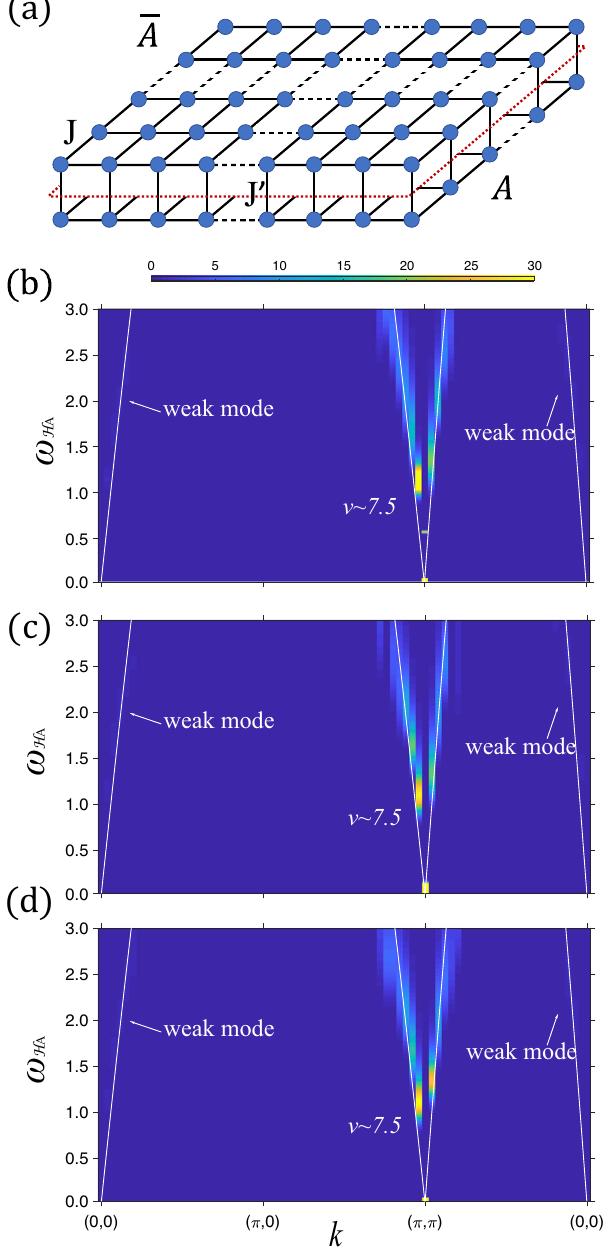
Fig.4|ESofHeisenbergbilayeracross(2+1)O(3)transition.a Antiferromagnetic Heisenbergbilayer.Thereddashedlinecutitintotwoentangledconstituentlayers, A and A . b The low-lying ES of in the Néel phase with L =50, J 0 =1 : 732, J =1 and β =100, β A =32. c The low-lying ES at the quantum critical point with L =50, J 0 =2 : 522, J =1 and β =100, β A =32. d The low-lying ES in the dimerized phase with L =50, J 0 =3, J =1 and β =100, β A =32. We show the obtained ES along the high- symmetry path (0,0) − ( π ,0) − ( π , π ) − (0,0). The white line is fi tting to the data q ffiffiffiffiffiffiffiffiffiffiffiffiffiffiffiffiffiffiffiffiffiffiffiffiffiffiffiffiffiffiffiffiffiffiffiffiffiffiffiffiffiffiffiffiffiffiffiffiffiffiffiffi ð cos ð k x Þ + cos ð k y ÞÞ 2 , the linear spin wave for anti- with the dispersion 7 : 5 1 (cid:1) 1 4 ferromagnetic Heisenberg model on square